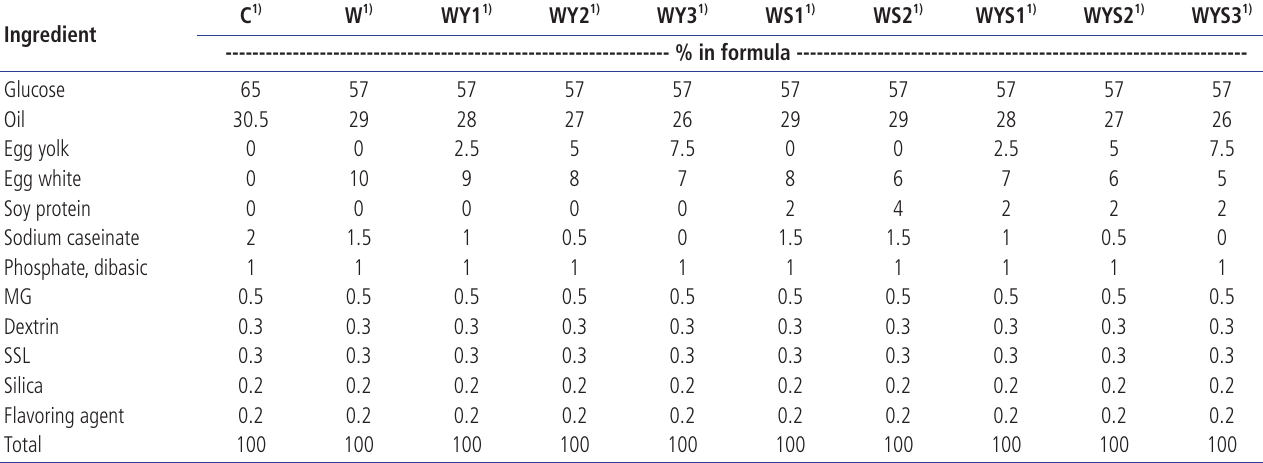
Table 1. The formula of non-dairy creamers